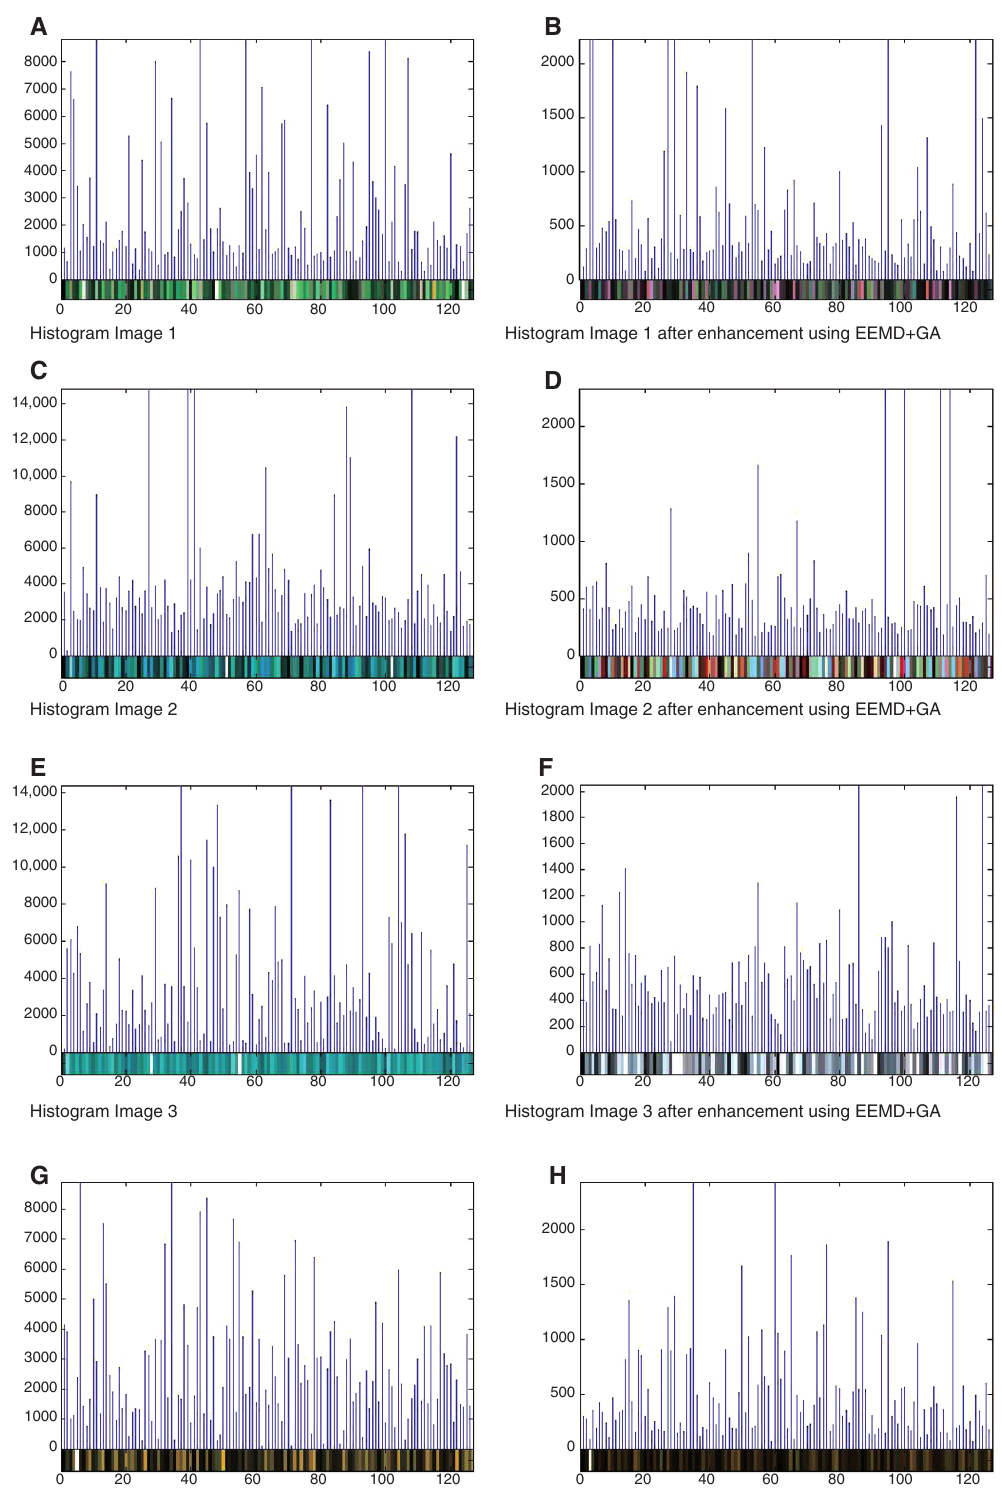
Figure 5. The Original and Enhanced Underwater Image Histograms using